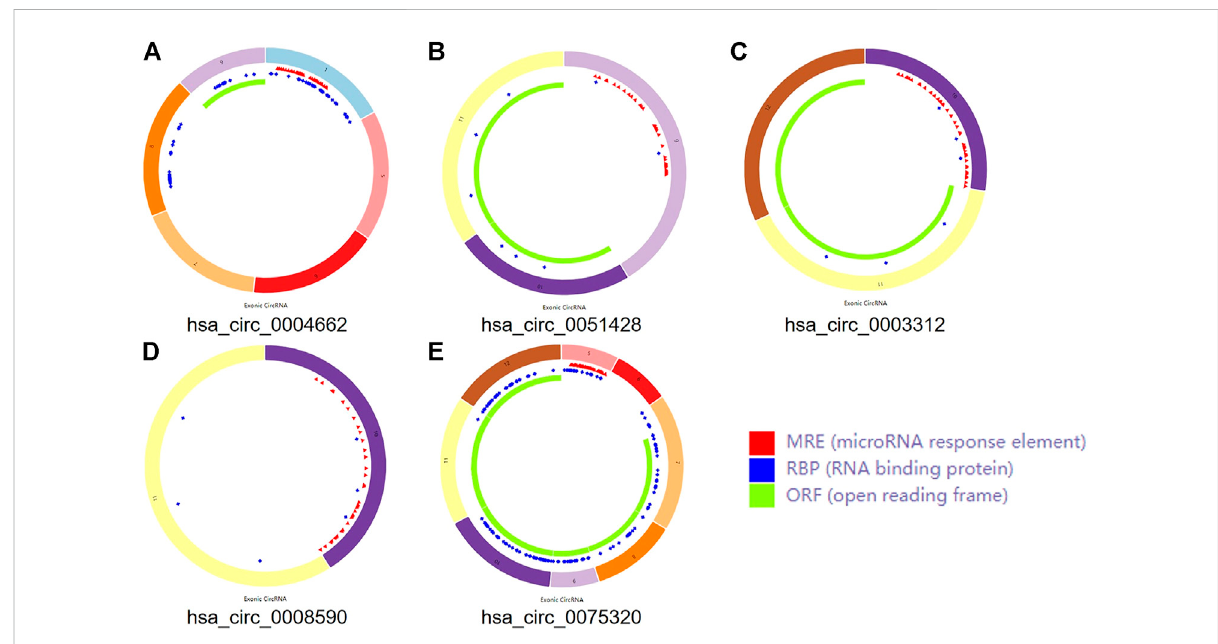
FIGURE 2 The structural patterns of the fi ve circRNAs. (A) hsa_circ_0004662. (B) hsa_circ_0051428. (C) hsa_circ_0003312. (D) hsa_circ_0008590. (E)